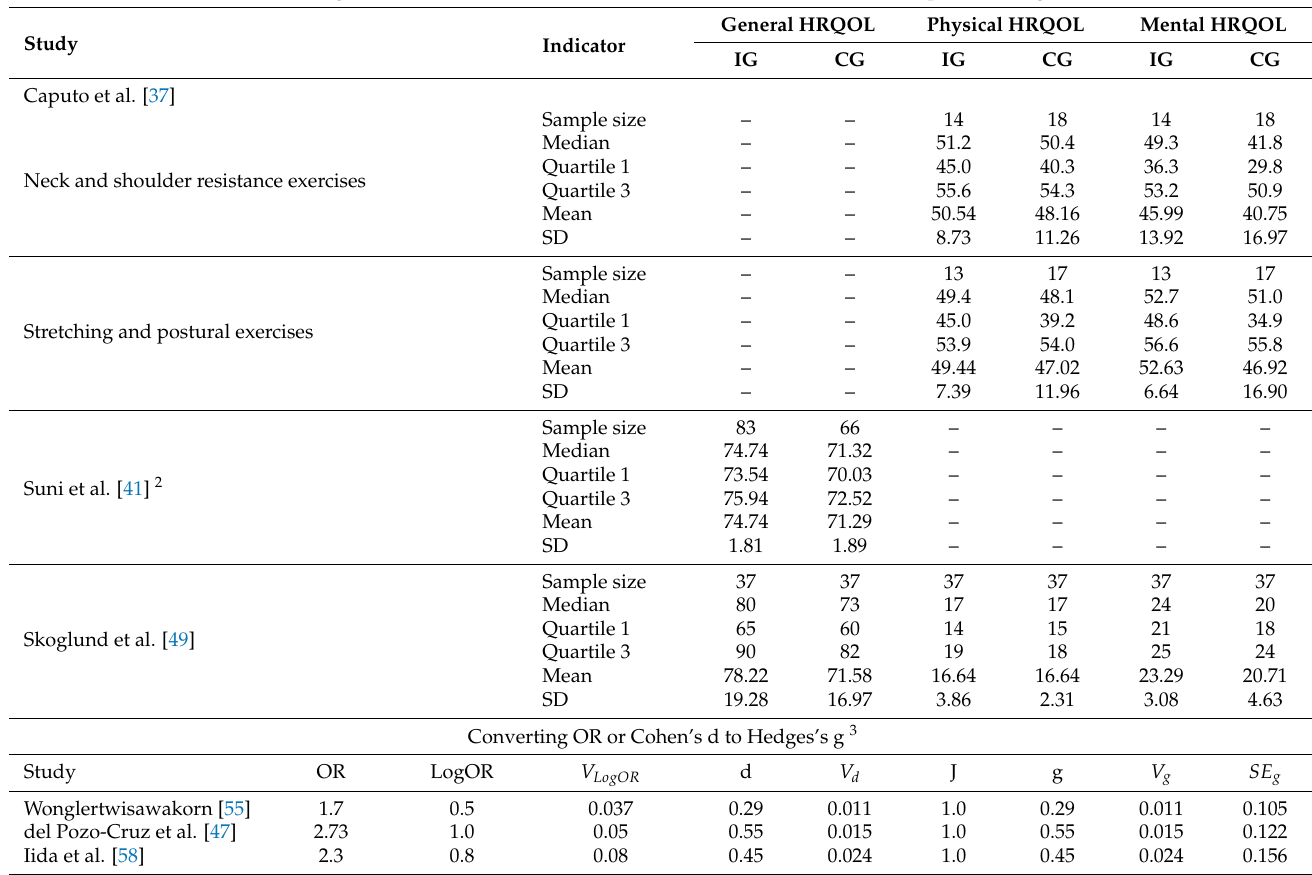
Table A3. Calculation of means and SDs using data extracted from the included studies and conversion of effect sizes to Hedges’s